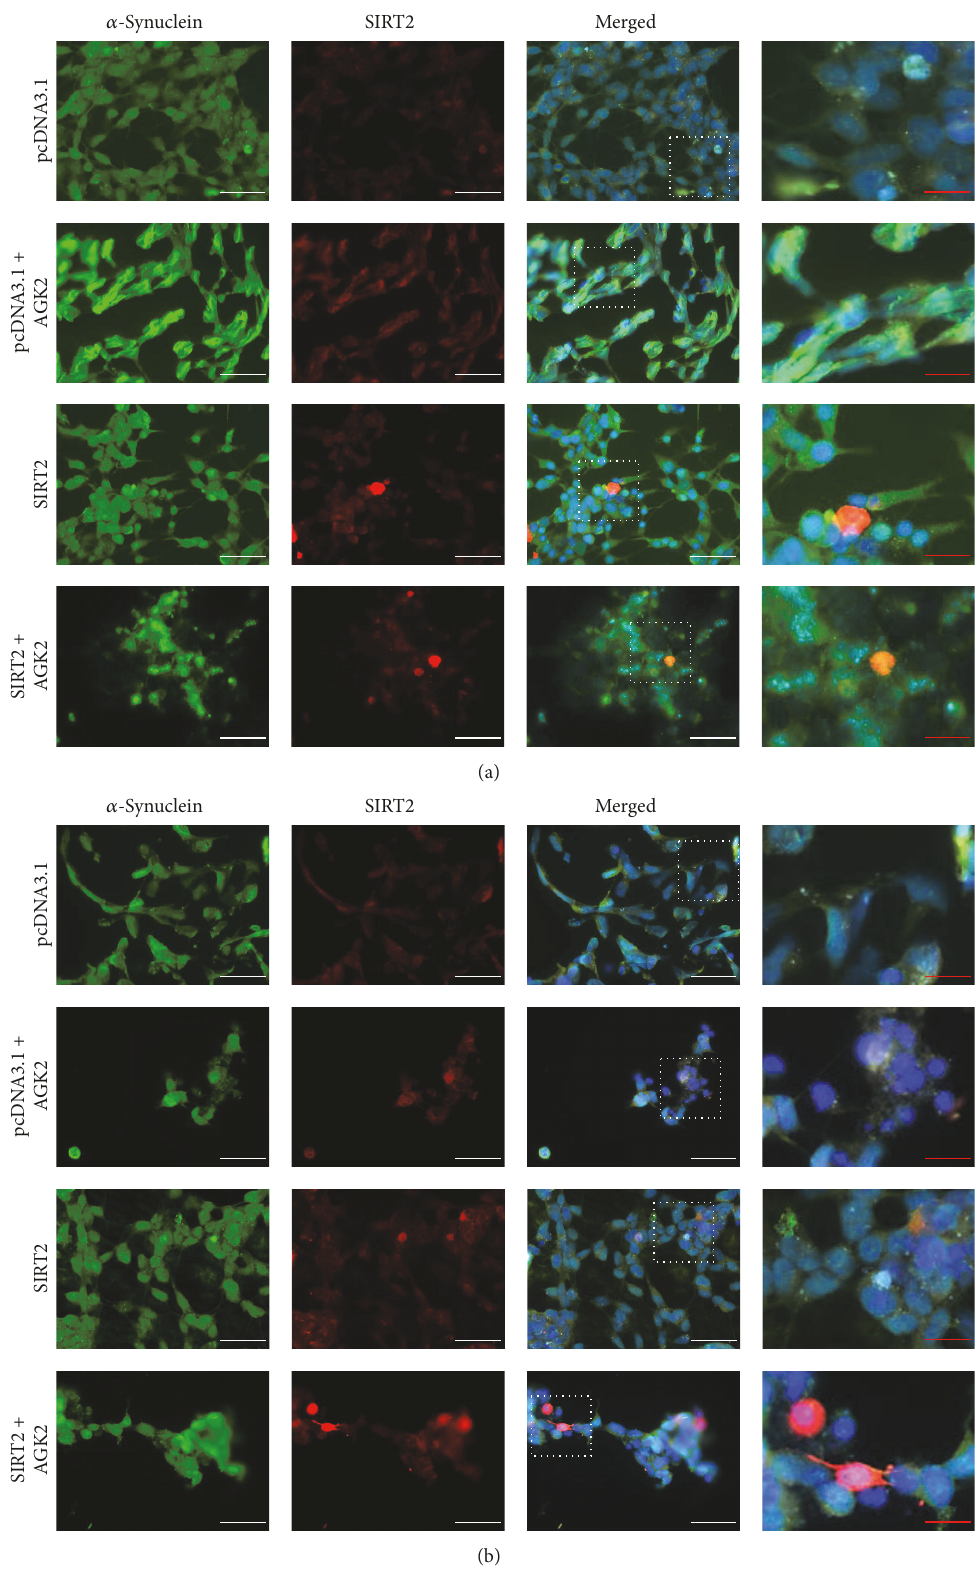
Figure3:LocalisationofSIRT2and 𝛼 -synucleinindiquattreatedSH-SY5Ycells.CellulardistributionofSIRT2andphospho- 𝛼 -synucleinwas determined using fluorescent immunocytochemistry. Images show 𝛼 -synuclein immunostaining, SIRT2 immunostaining, and all staining merged including DAPI in 20 𝜇 M diquat treated cells. Scale bars, white scale bar = 50 𝜇 M and red scale bar = 20 𝜇 M; magnification: 40x. (a) represents 0.2% PBS and (b) represents 20 𝜇 M diquat treated SH-SY5Y